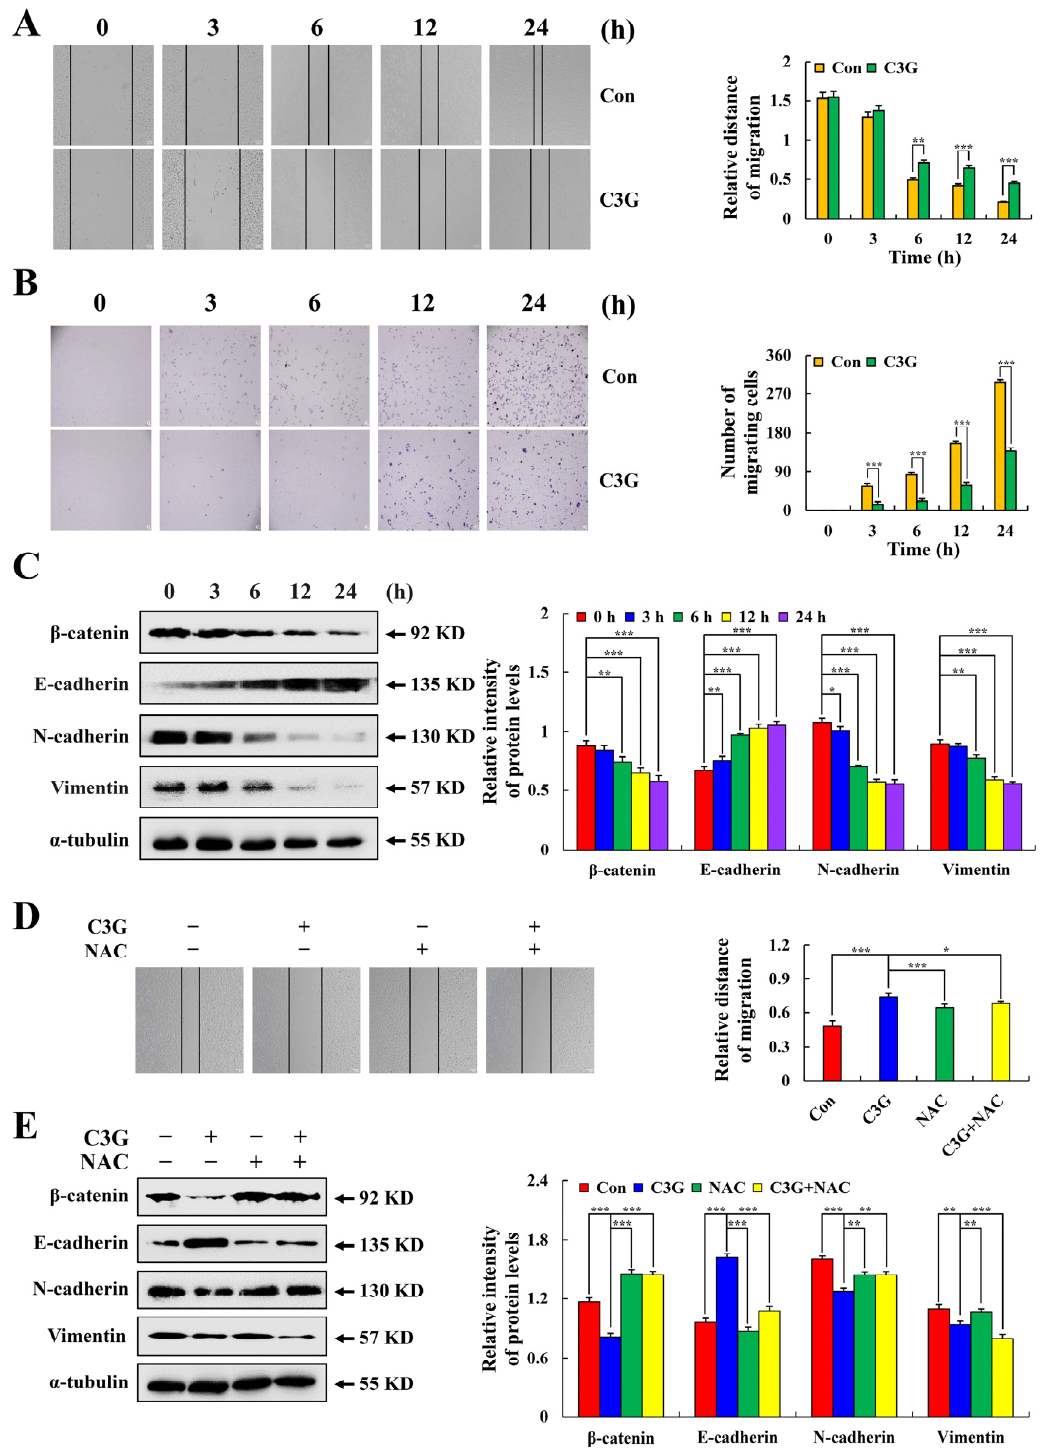
Figure 7. Inhibitory effect of C3G on cell migration in MKN-45. ( A ) Cell migration was